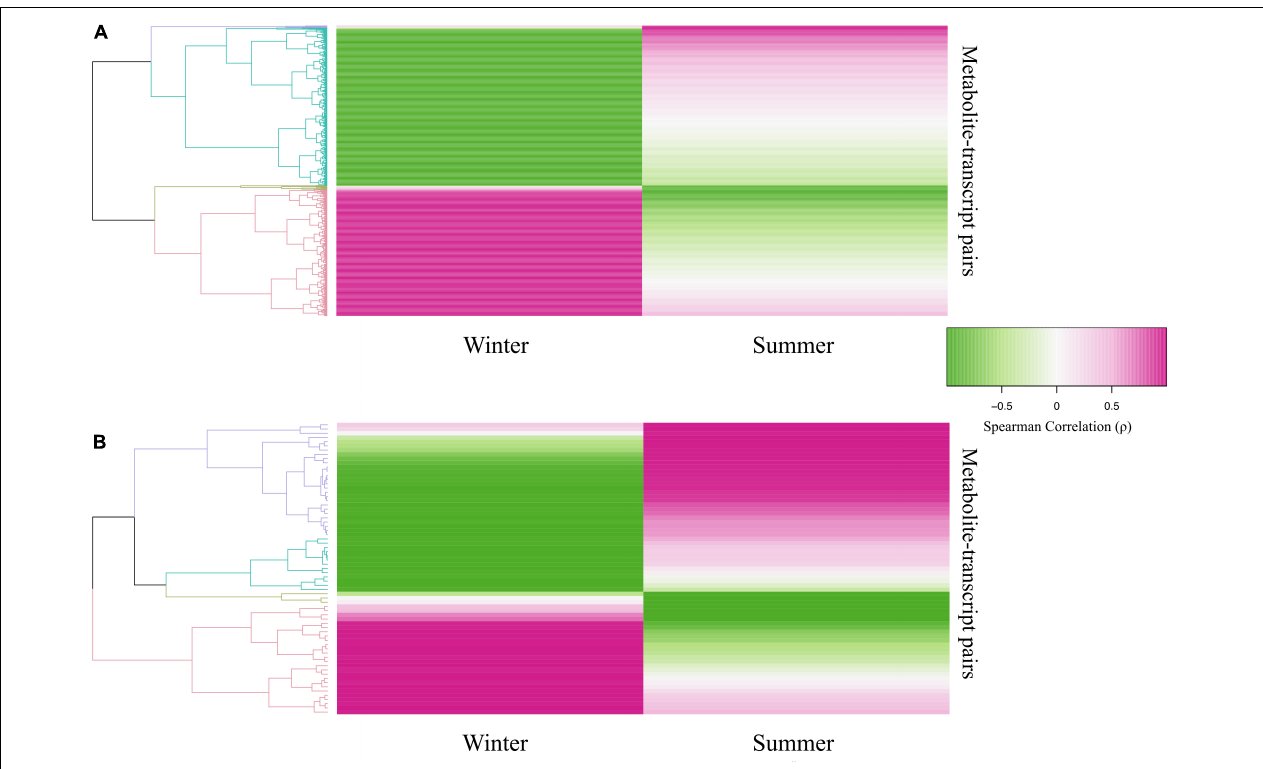
FIGURE 9 | Results of the integration through linear model approach (IntLIM; Siddiqui et al., 2018) applied to the transcriptomic and metabolomic data sets of pectoralis muscle from black-capped chickadee and American goldfinch. Clustering of identified transcript-metabolites pairs (Benjamini-Hochberg FDR—adjusted interaction p -value < 0.10, and a Spearman correlation difference > | ± 0.5|) in (A) Black-capped chickadee and (B) American goldfinch. Fuchsia, Winter correlated; Green, Winter